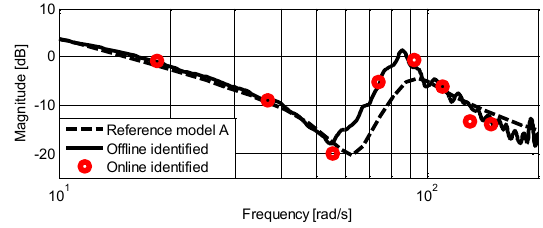
Figure 7: Online-identified frequency response points compared with the frequency response of reference model A and the offline-identified model. The red dots are the identified points with the proposed online